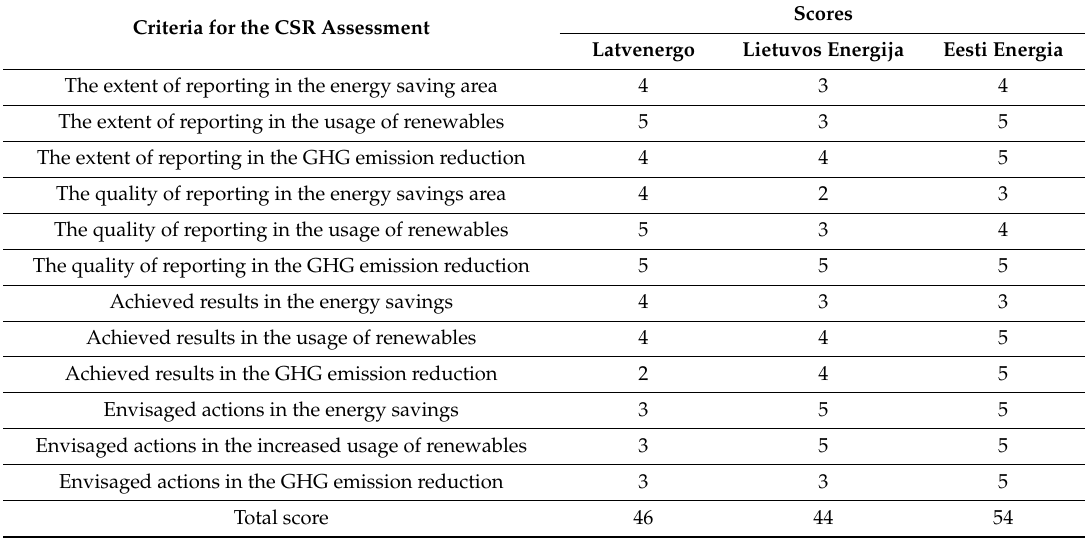
Table 7. The ranking of three energy utilities from the Baltic States. Source: created by the authors. Criteria for the CSR Assessment